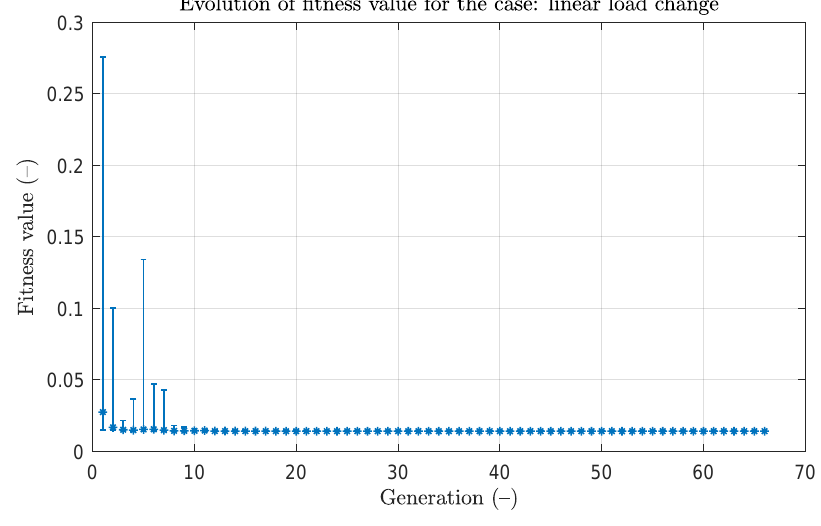
Figure 14. Evolution of fitness value for the case of linear load change.